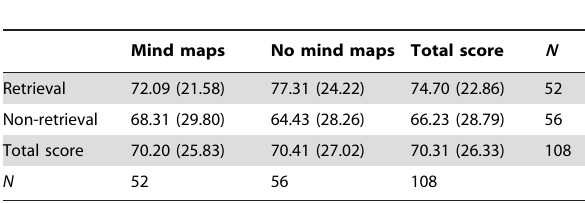
Table 1. Mean percentage scores (SDs) and sample sizes for Experiment